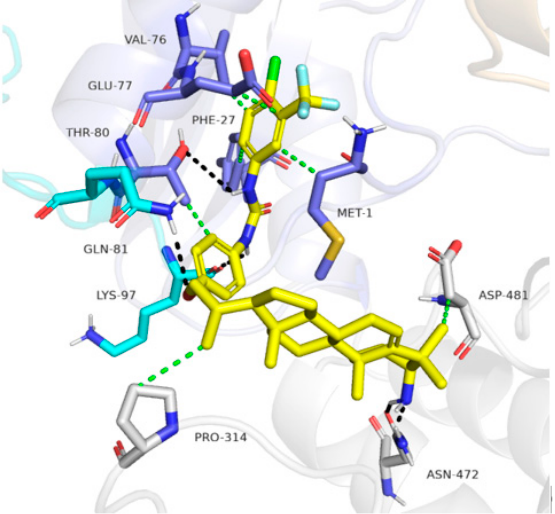
Figure 5. Predicted interactions of 5ba and SHP1 in open conformation. Adjacent amino acids of N- SH2 and PTP domains are shown blue and gray, respectively. BG loop is shown in cyan. Black dashed lines indicate hydrogen bond interactions. Green dashed lines indicate hydrophobic interactions.